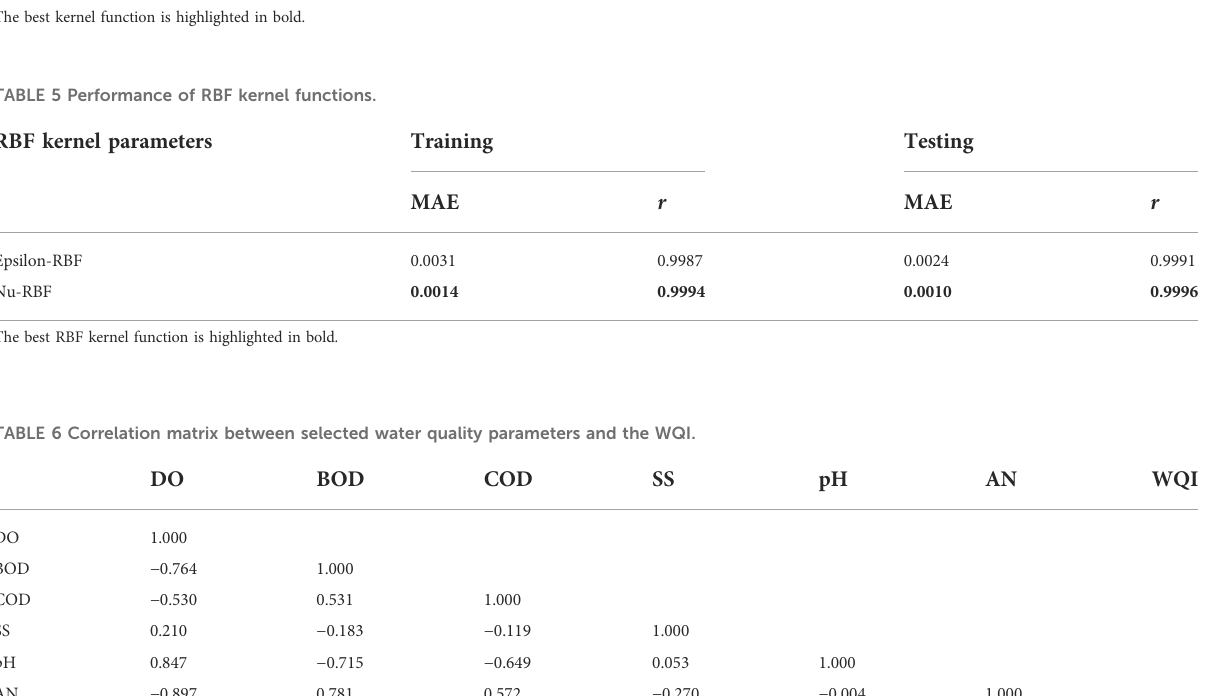
The best kernel function is highlighted in bold.